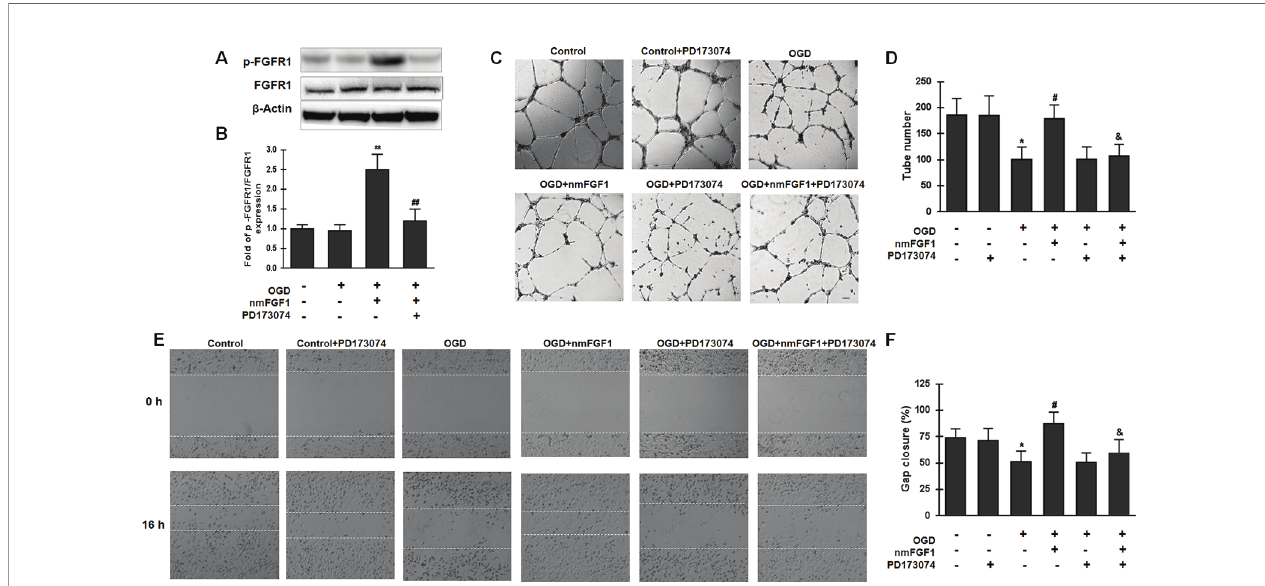
FIGURE 5 | Non-mitogenic fi broblast growth factor 1 (nmFGF1) promoted angiogenesis through FGFR1 activation. (A) Representative image of western blot analysis for FGFR1 and p-FGFR1 expression. (B) Quanti fi cation of relative protein levels of p-FGFR1 and FGFR1. (C) Representative images for the analysis of the effects of cotreatment with the FGFR1 inhibitor PD173074 and nmFGF1 (100 nM) on tube formation ability of oxygen-glucose deprivation (OGD)-treated HBMECs. (D) Quanti fi cation of the effects of nmFGF1 and PD173074 cotreatment on the number of capillary-like tubes in OGD-treated cells. (E) Representative images showing the effects of PD173074 and nmFGF1 (100 nM) co-administration on wounding healing in OGD-stimulated cells. (F) Quanti fi cation of the effects of PD173074 and nmFGF1 (100 nM) co-administration on gap closure in OGD-treated cells. Date are means ± SEM (n = 6). *p < 0.05 compared to control group, # p < 0.05 as compared to the OGD-treated group, & p < 0.05 as compared to the nmFGF1 treated